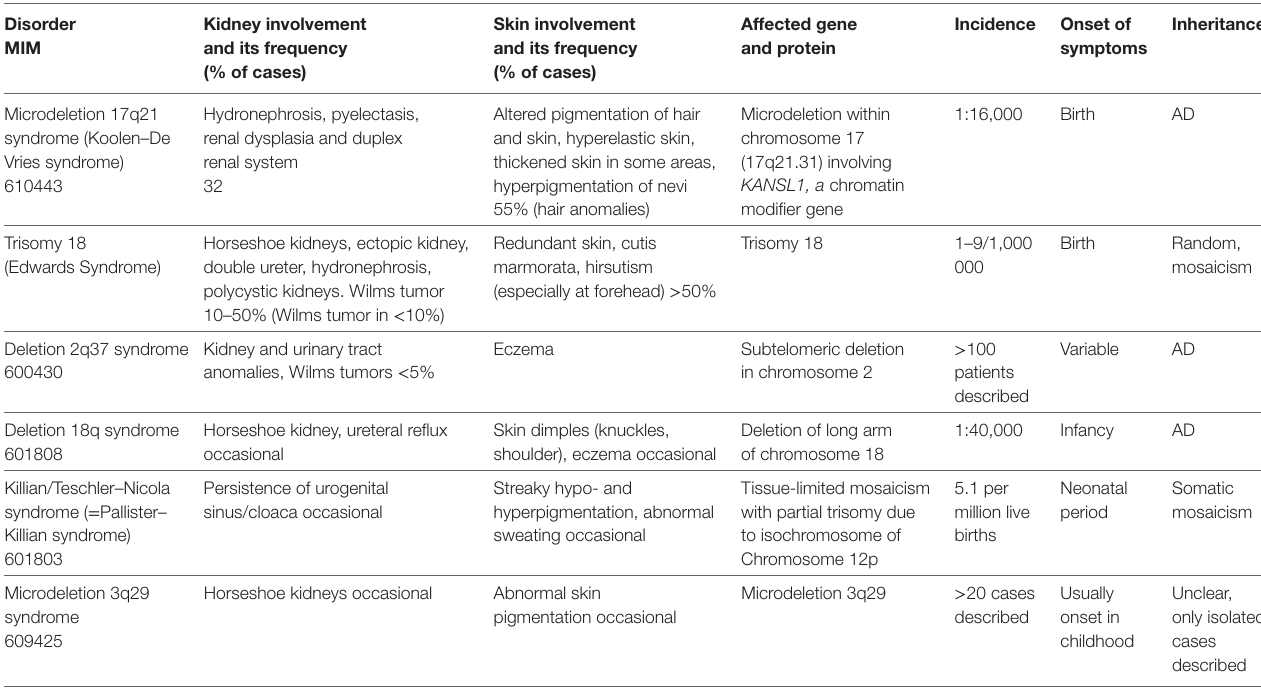
TABLe 6 | Chromosome anomalies with cutaneous and reno-urinary